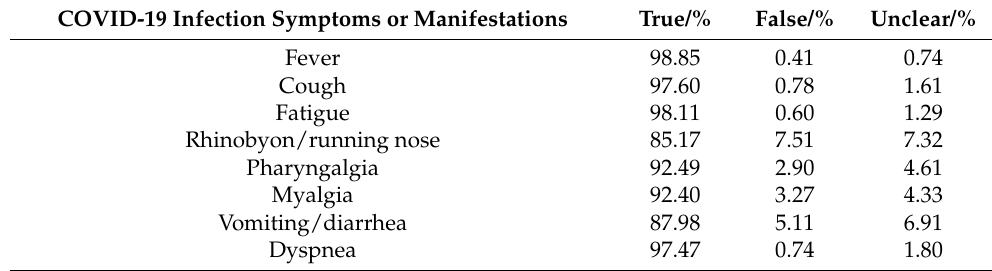
Table 4. Participants’ responses to symptoms and manifestations of COVID-19 infection.